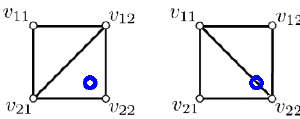
Figure 4: The two possible triangulations of a square involving four incident pixels v ij and the projected LiDAR point in blue.